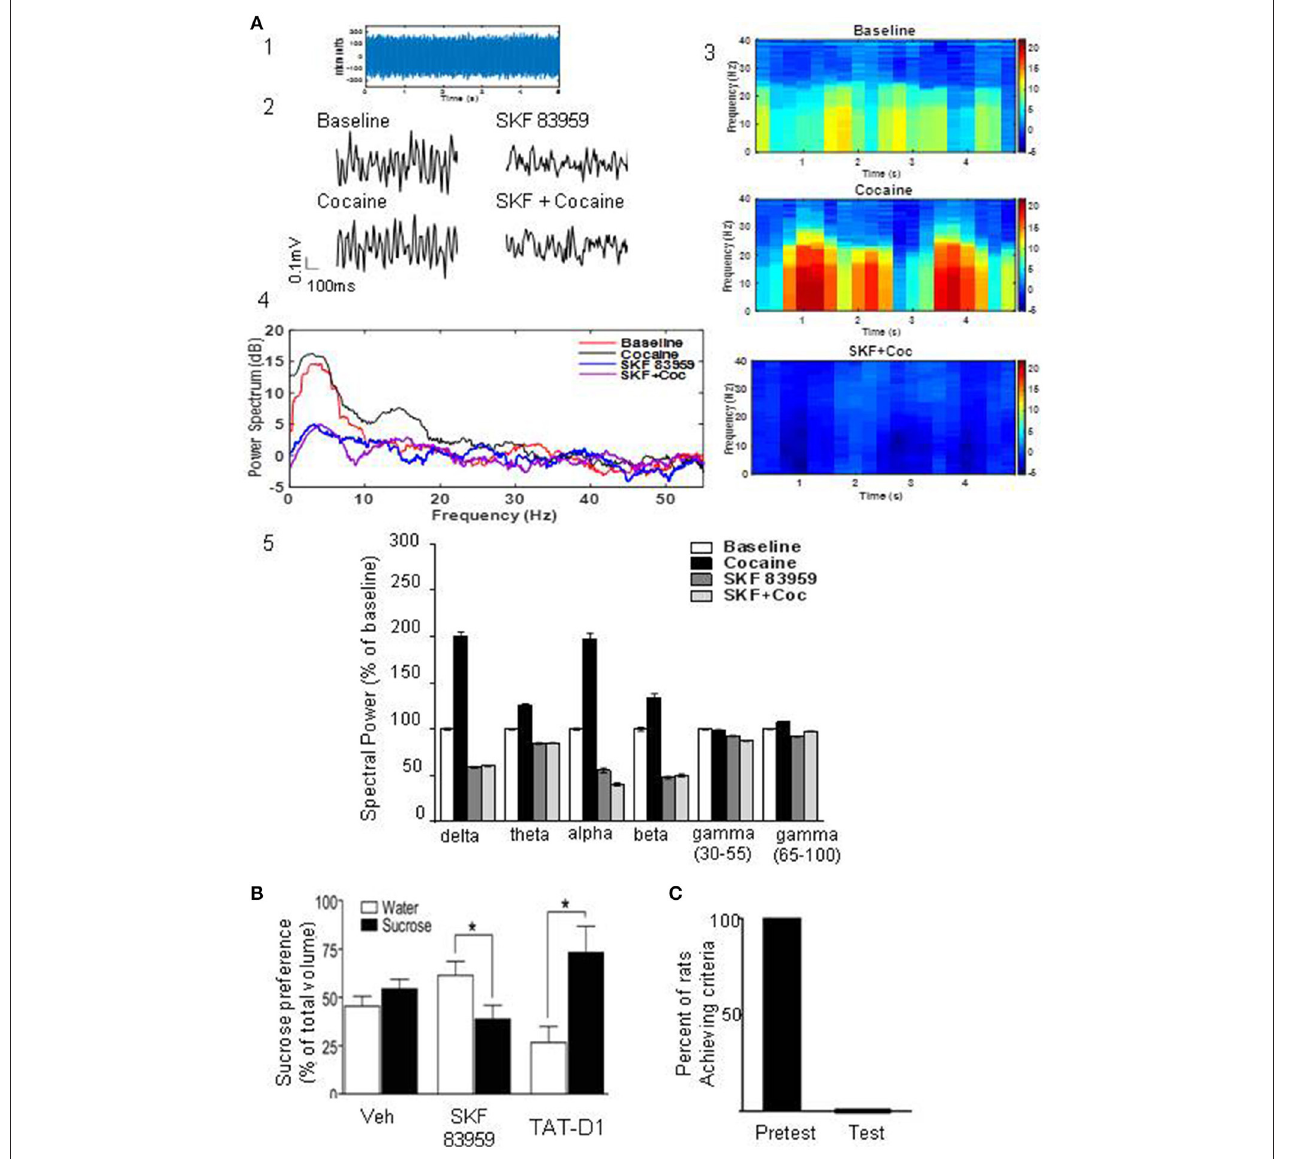
FIGURE 6 | Heteromer D1-D2 activation inhibits cocaine-induced changes in LFPs and modulates food reward. (A) Analysis of local field potentials (LFPs) from a sample 5s epoch of baseline LFP recordings derived from rat NAc (A1) . Representative 100ms LFP amplitude recordings of baseline and recordings derived from rat NAc treated with cocaine, SKF 83959 or both drugs (A2) . Spectrograms depicting time-frequency analysis showing the relative change in power of specific frequencies across the 5s epoch of rats treated with cocaine or cocaine + SKF 83959 in comparison to the baseline (A3) . Representative power spectrum showing acute cocaine induced increase in spectral power at lower frequencies ( < 30Hz) which was suppressed by pretreatment with SKF 83959 (A4) . Drug-induced changes in mean spectral power at select frequencies are also shown (A5) . (B) Sucrose preference test. A single injection of SKF 83959 in a two bottle free choice paradigm significantly decreased the proportion of sucrose consumed but had no effect on water consumed (1st and 2nd set of bars). Administration of TAT-D1 (300 pmoles i.c.v) significantly increased the proportion of sucrose consumed (3rd set of bars). Results represent the mean ± SEM from 8 to 9 rats/condition. * p < 0.05 represents significant difference from control. (C) Activation of the D1-D2 heteromer abolished the motivation of rats to search for and consume a palatable sweet treat. Rats that had been successfully trained (pretest) were administered a single injection of SKF 83959 (1.5 mg/kg s.c.), placed in the radial arm maze and the number of trials required to reach the set criteria (11 consecutive correct choices) were documented. In each animal tested (Test), SKF 83959 abolished the motivation of the animals to search for and consume the food reward.